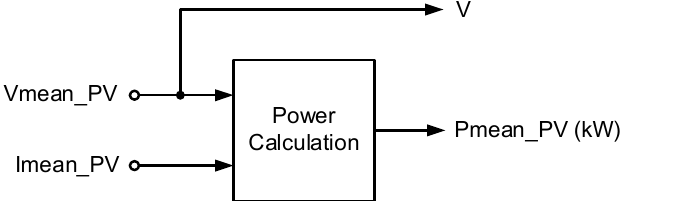
Figure 11. Diagram of the measuring system of the power of photovoltaic modules implemented in Matlab/Simulink.